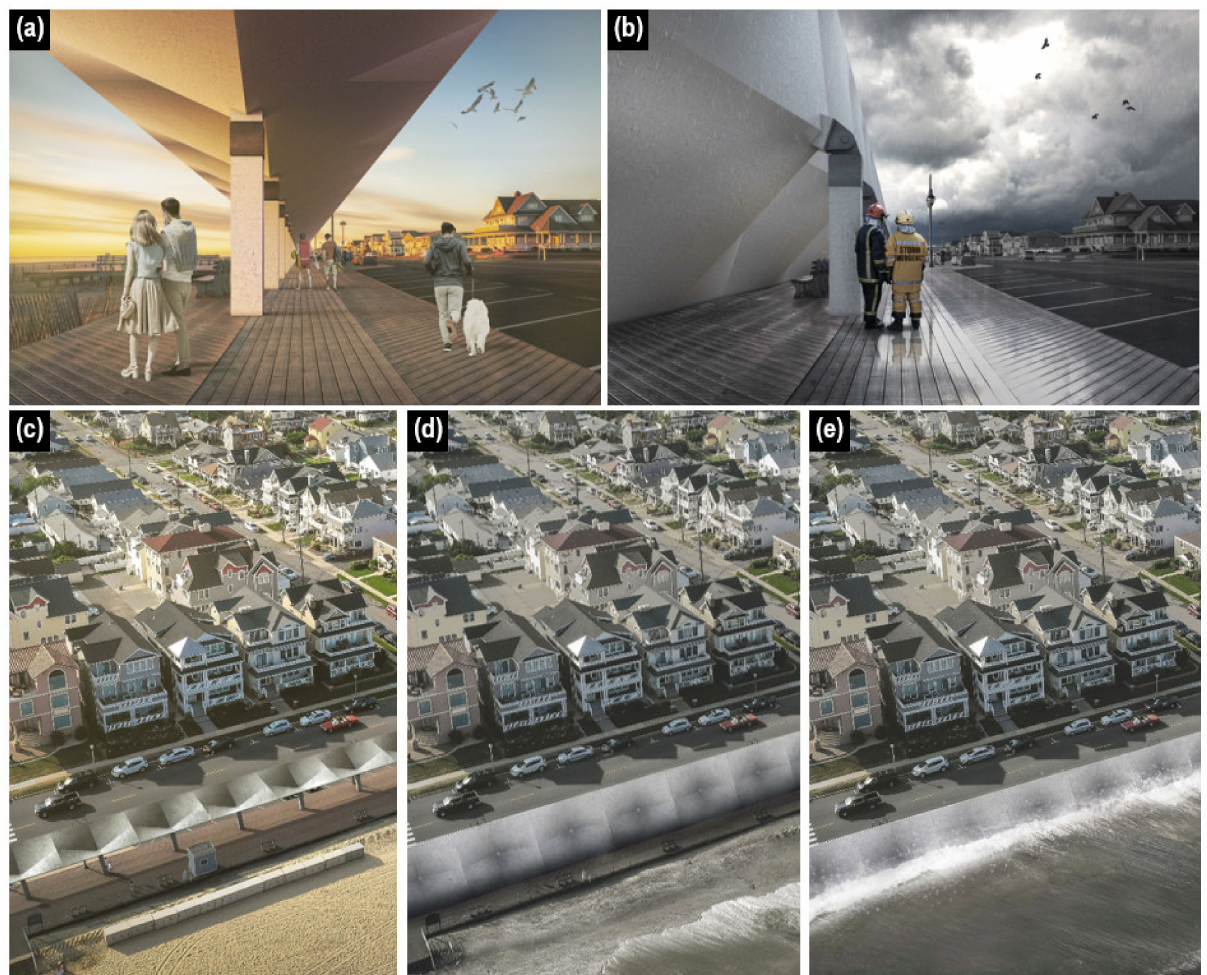
Figure 1. Architectural rendering of kinetic umbrellas in the ( a ) upright and ( b ) deployed position; aerial view of umbrella system in the ( c ) upright position, and when deployed ( d ) prior to and ( e ) during a storm surge event also shown. Images courtesy of FotosForTheFuture/Shutterstock.com with modifications by Mauricio